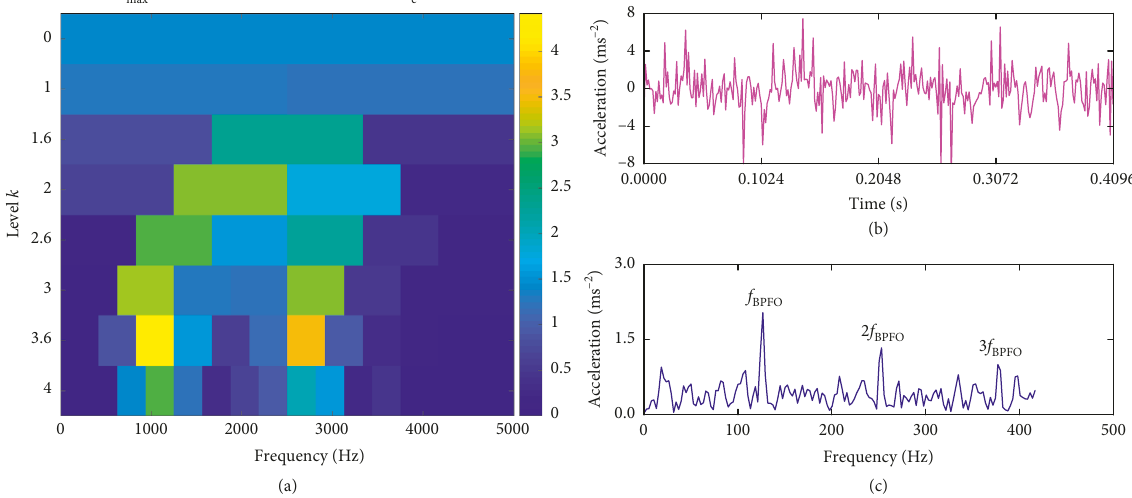
Figure 30: Processing results obtained using (a) spectra kurtosis: (b) purified signal; (c) Hilbert envelope